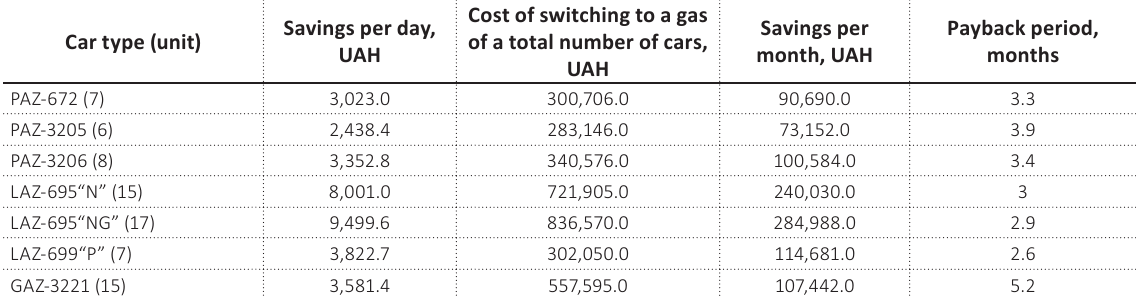
Table 3. Сost-benefit calculations